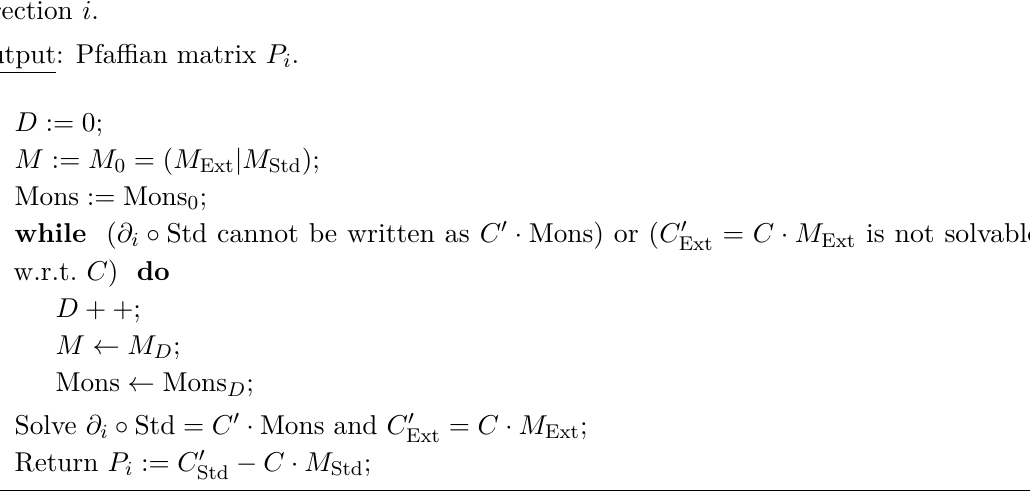
, h , . . . of a zero-dimensional ideal I ⊂ R , 1 2